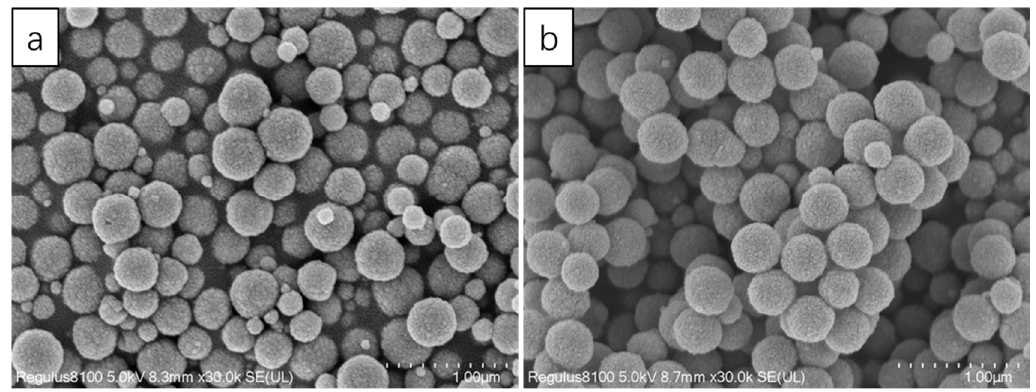
Figure 5. SEM image of Fe 3 O 4 . ( a ) Without using PEG; ( b ) using PEG.